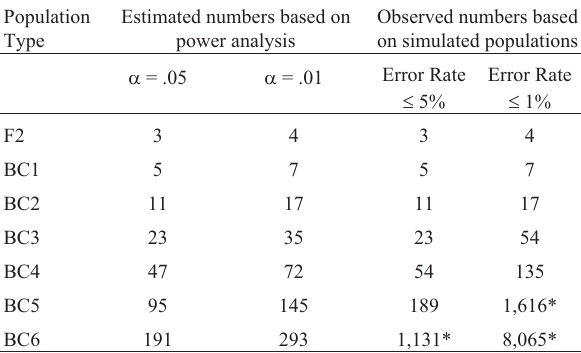
*Calculated using non-linear equations derived from observed error rate curves in simulated populations (Figure 5)